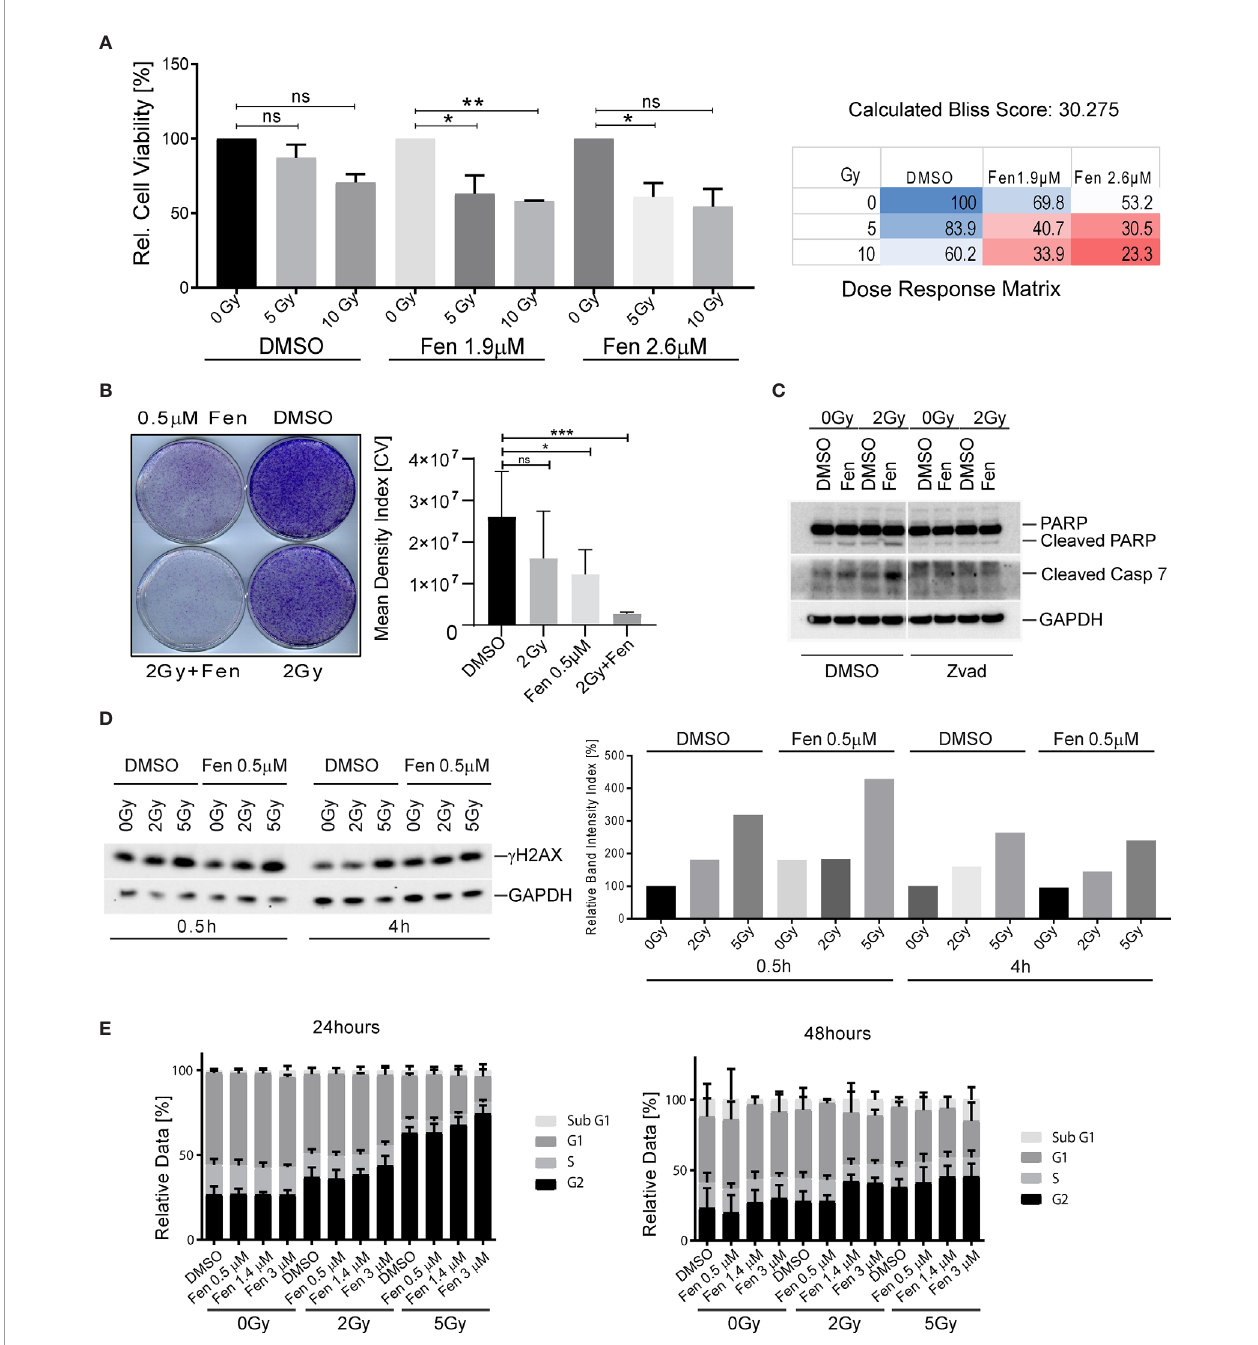
FIGURE 1 | Combinatorial treatment of aRMS cells with fenretinide and ionizing radiation leads to enhanced cell death. (A) Cell viability of Rh4 cells treated with fenretinide in combination with ionizing radiation at the indicated concentrations and dosages as determined by WST assay (left panel). Synergy was calculated according to the Bliss independence model using the SynergyFinder WebApp (33) (right panel). ns: p > 0.05, *p</=0.05, **p</=0.01. (B) Clonogenicity assay with Rh4 cells treated with fenretinide and ionizing radiation at the indicated concentrations and dosages. Cells were grown for 12 days after treatment (left panel). Right panel shows the mean density index of the crystal violet (CV) stainings (n = 3). ns: p > 0.05, *p</=0.05, ***p</=0.001. (C) Western Blot using whole cell lysates from Rh4 cells treated with 0.5 m M fenretinide and 2 Gy IR. Cleaved PARP, Caspase 7 and GAPDH were detected. (D) Western Blot using whole cell lysates from Rh4 cells treated with 0.5 m M fenretinide and either 2 or 5 Gy IR. Phosph-H2AX and GAPDH were detected (left panel). Quanti fi cation of individual band intensities assessed by BioRad Software: Depicted are the normalized ratios of g H2AX and GAPDH (right panel). (E) Cell cycle analysis determined by fl ow cytometry of Rh4 cells after 24 and 48 h treatment with fenretinide and IR at the indicated concentrations and dosages. Staining with propidium iodide (20